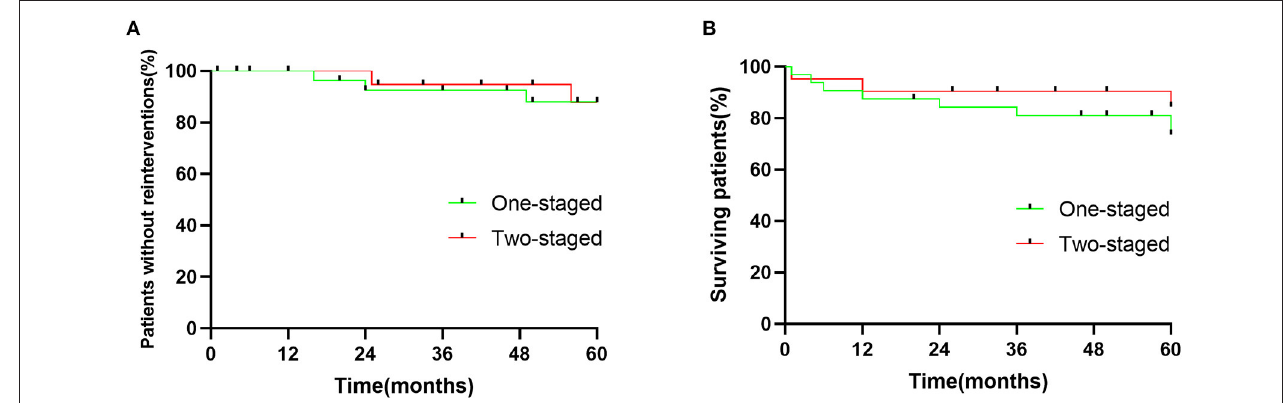
FIGURE 1 | (A) Cumulative Kaplan-Meier estimate of patients without reinterventions after endovascular repair of multilevel lesions via one-staged and two-staged repair. p = 0.9006. (B) Cumulative Kaplan-Meier estimate surviving rate of patients after endovascular repair of multilevel lesions via one-staged and two-staged repair. p =